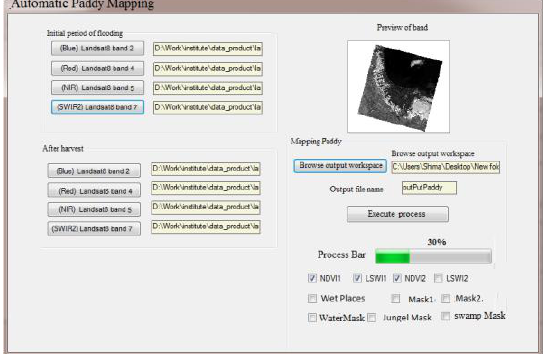
Figure 6. Paddy Mapping Interface under progress